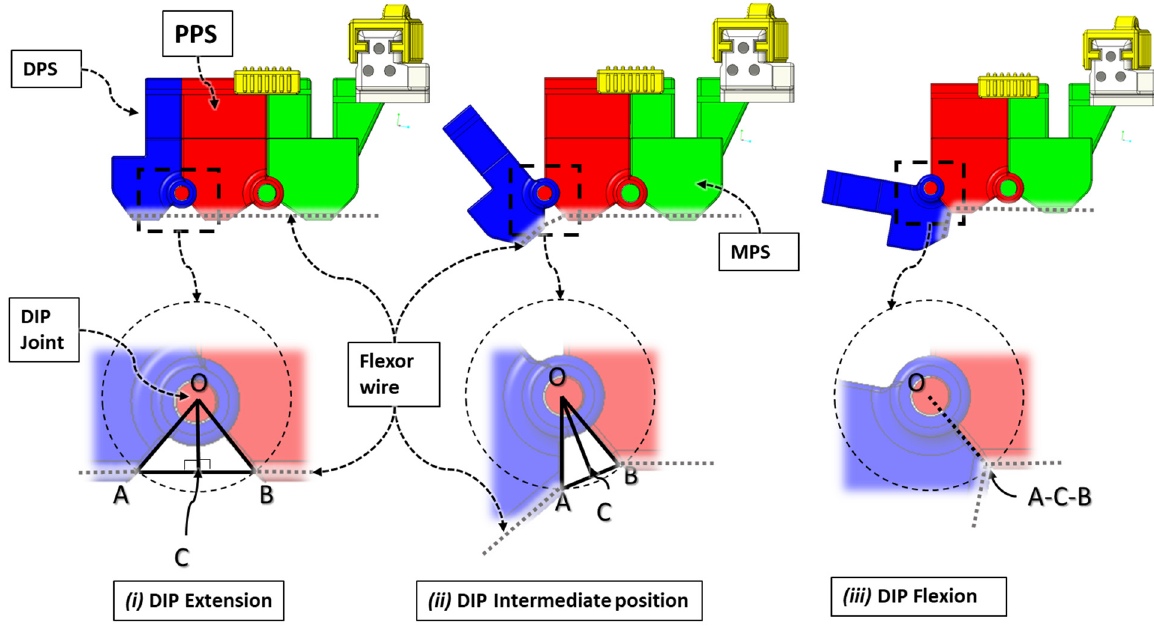
Figure 11. Relation between varying DIP joint flexion angles and effective flexion wire length.